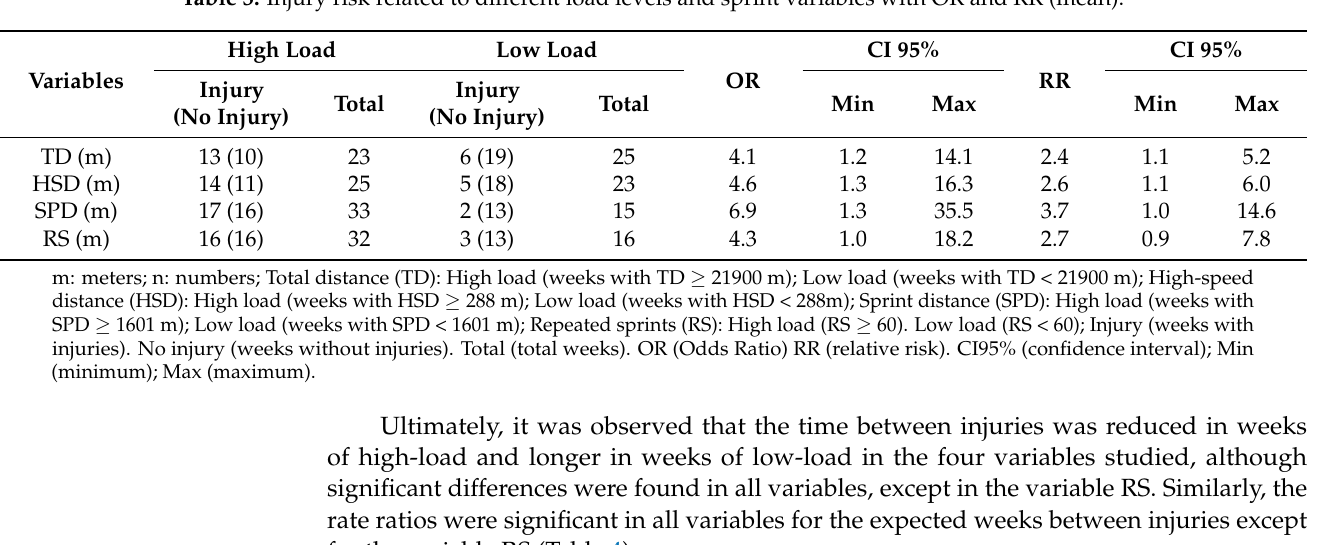
Table 3. Injury risk related to different load levels and sprint variables with OR and RR (mean).